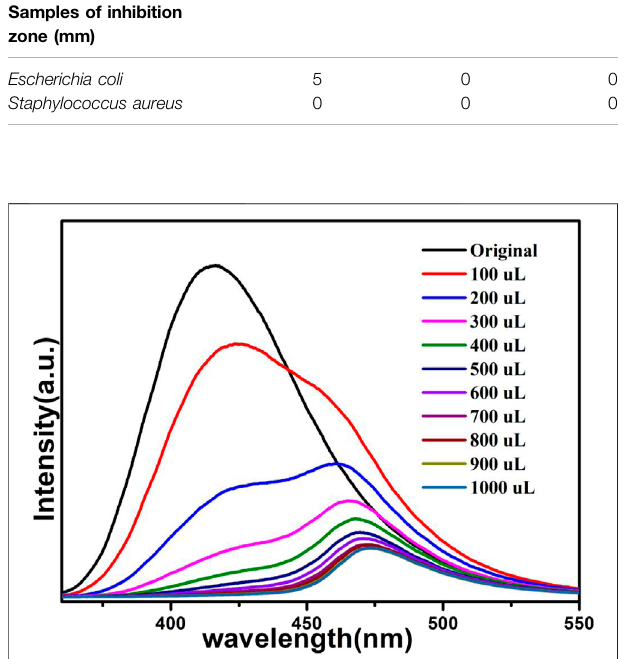
FIGURE 11 | Fluorescence of 1a in DMA containing different volumes of TNP (10 – 3